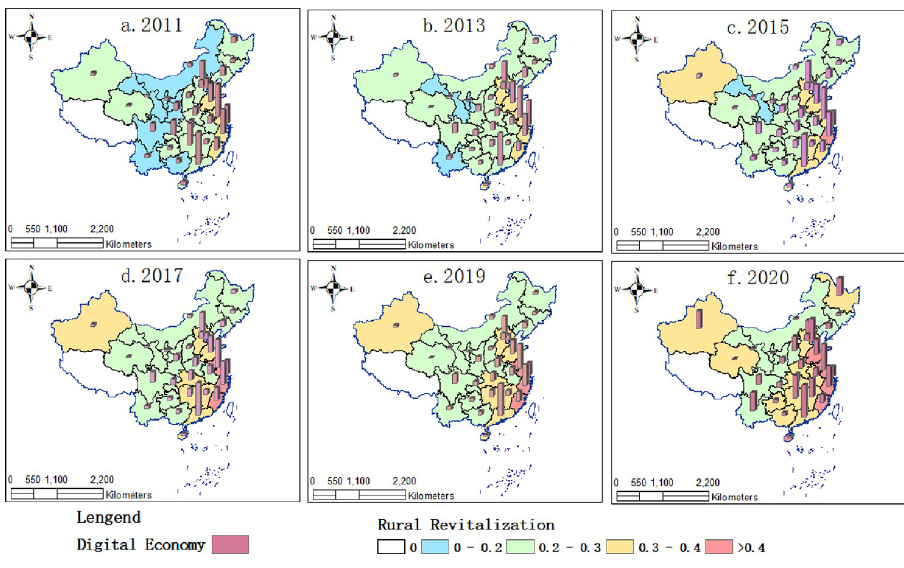
Fig 3. Spatial and temporal distribution of the development level of China’s digital economy and rural revitalization.